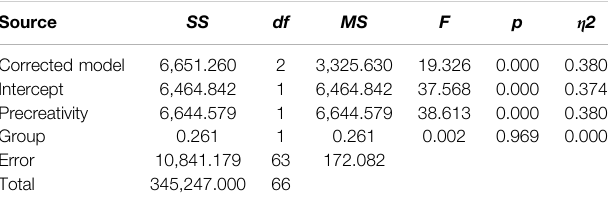
TABLE 6 | ANCOVA analysis to compare scienti fi c creativity among different groups of students ( n (cid:1) 66). Source SS